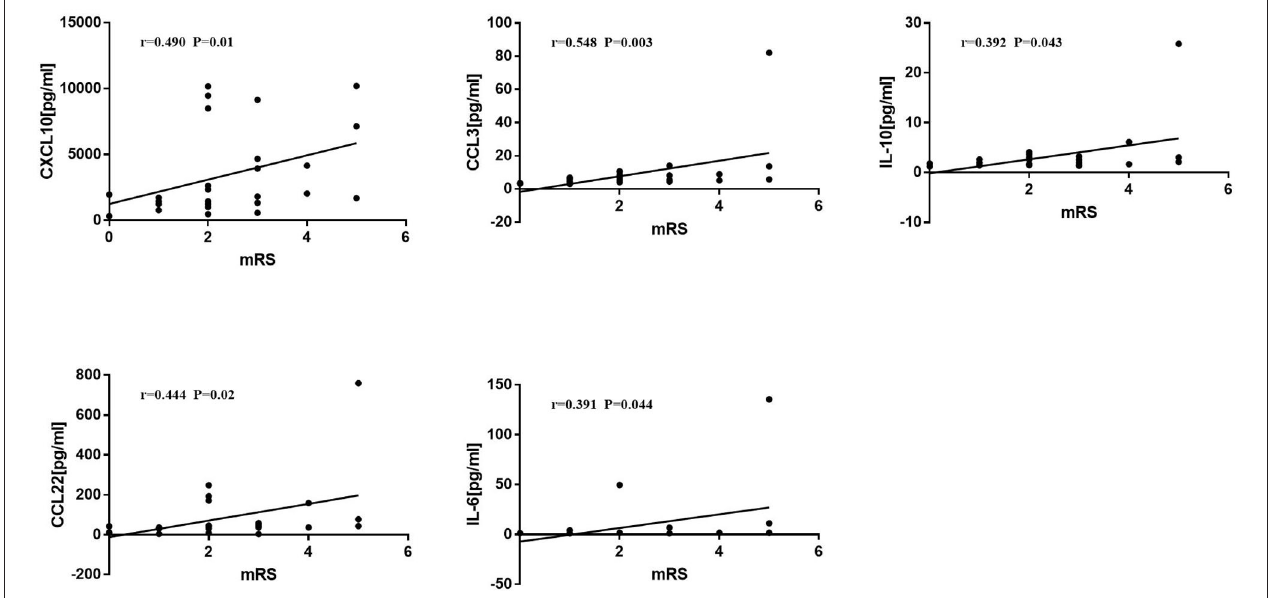
FIGURE 4 | Correlations between Modified Rankin score (mRS) and cytokines/chemokines. Spearman correlation analysis was used. mRS was positively correlated with CXCL10, CCL3, IL-10, CCL22, and IL-6 ( p < 0.05).